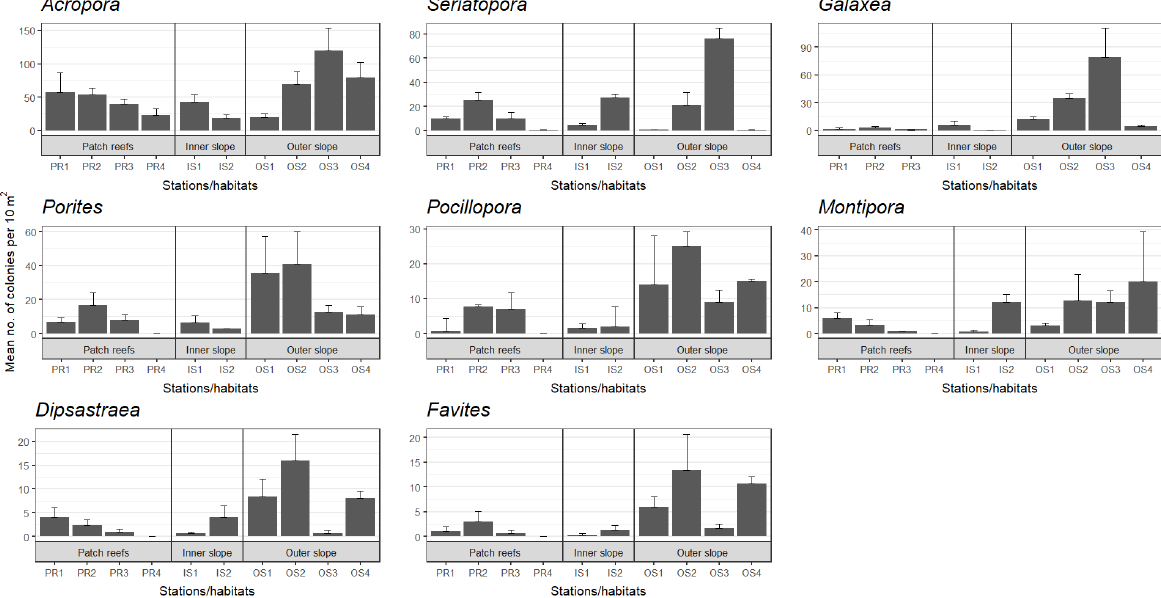
Figure 6. Mean abundance of colonies of the eight major coral genera at the 10 stations located on the three major habitats (PR: patch reefs, IS: inner slope, and OS: outer slope). Error bars represent standard error.